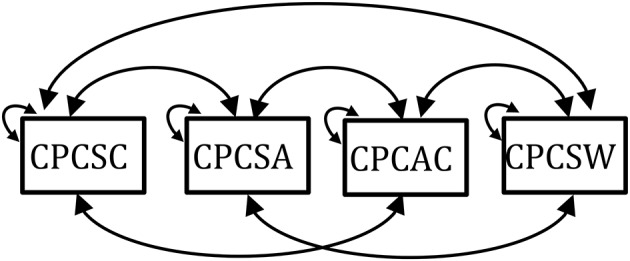
The saturated model.